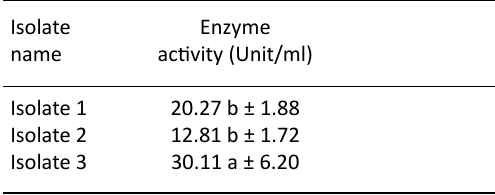
Table 4. Protease activity from different isolates in